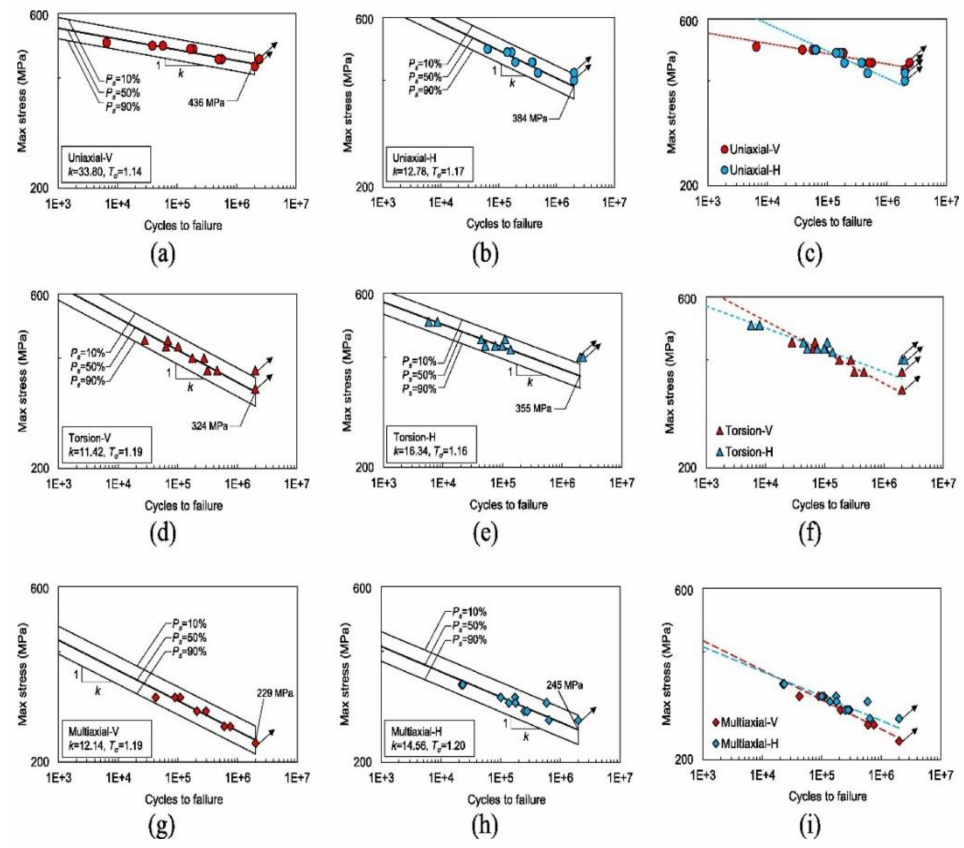
Figure 14. Fatigue test data for ER70S-6 specimens under ( a – c ) uniaxial, ( d – f ) torsion, and ( g – i ) multiaxial loading conditions. Reprinted with permission from ref. [73]. 2022,